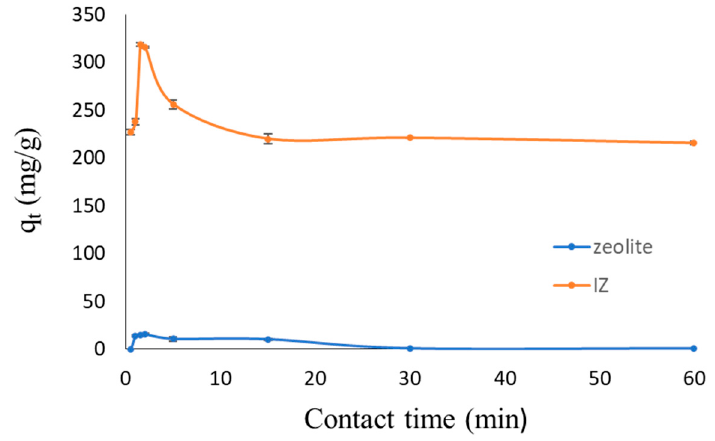
Figure 10. Relationship curve of zeolite X and IZ X contact time toward adsorption of